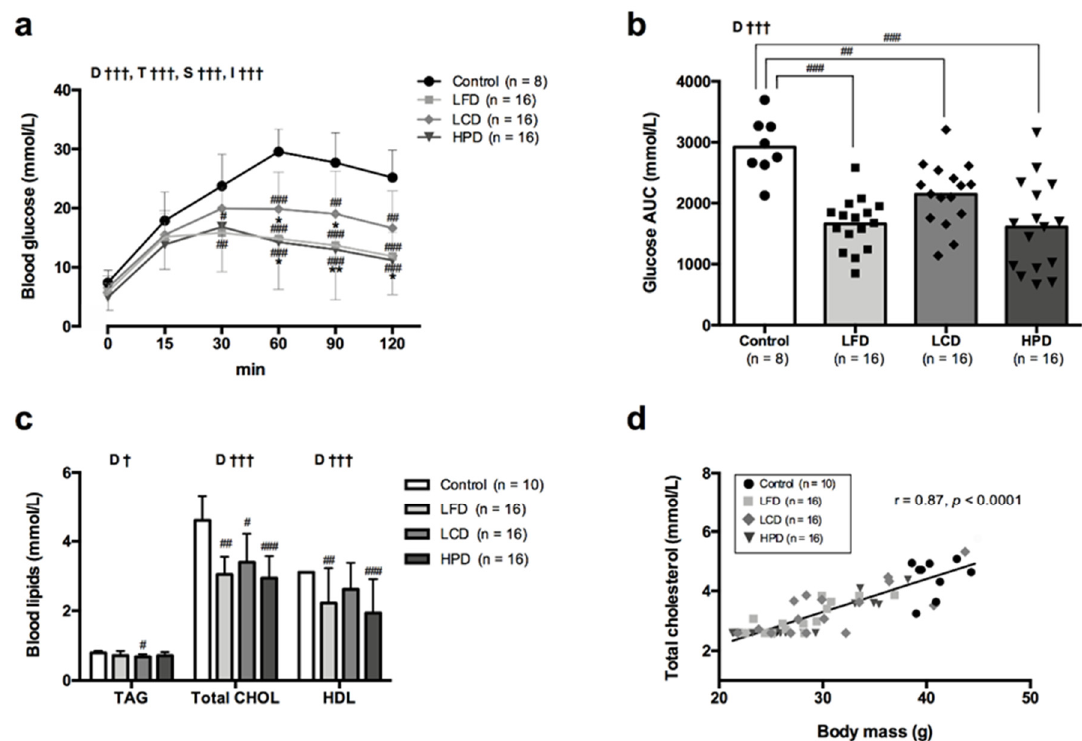
Figure 2. Blood glucose kinetics ( a ), blood glucose area under the curve (AUC) ( b ), blood lipid levels ( c ) and correlation between total blood cholesterol and body mass ( d ) following a 6-week caloric restriction on low-fat (LFD), low-carbohydrate (LCD), high-protein (HPD) compared to the age-matched obese controls. Abbreviations for ( c ): TAG, triacylglycerol; CHOL, cholesterol; HDL, high density lipoprotein. Data are means ± SD ( a , c ) or means with plotted individual values ( b ). Statistical analysis: ( a ) Two-way repeated measures ANOVA with Bonferroni’s post hoc analysis was performed for effects of diet group and time, respectively; ( b , c TAG ) One-way ANOVA with Bonferroni’s post hoc analysis was performed for diet group effect; ( c CHOL,HDL ) Non-parametric Kruskal-Wallis with Dunn’s post hoc analysis was performed for diet group effect. † p < 0.05, ††† p < 0.001 for effects of diet group (D), time (T), subject (S) and interaction (I). # p < 0.05, ## p < 0.01, ### p < 0.001 vs. obese controls. * p < 0.05, ** p < 0.01 vs. LCD group.